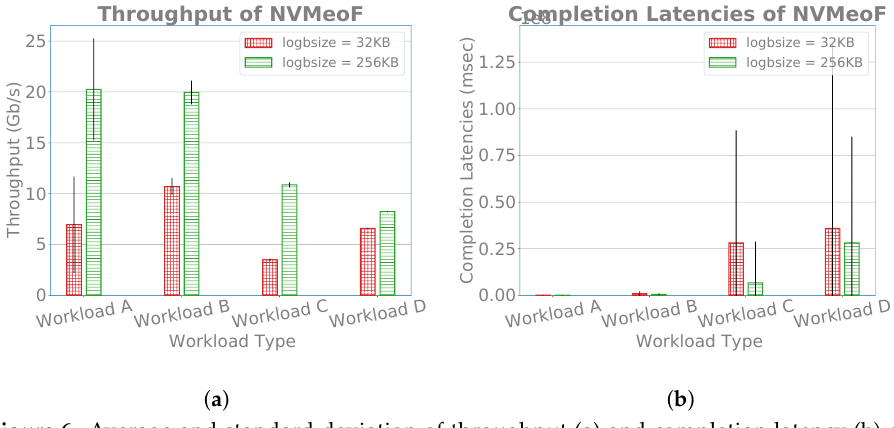
Figure 6. Average and standard deviation of throughput (a) and completion latency (b) of write performance in XFS for Ciena